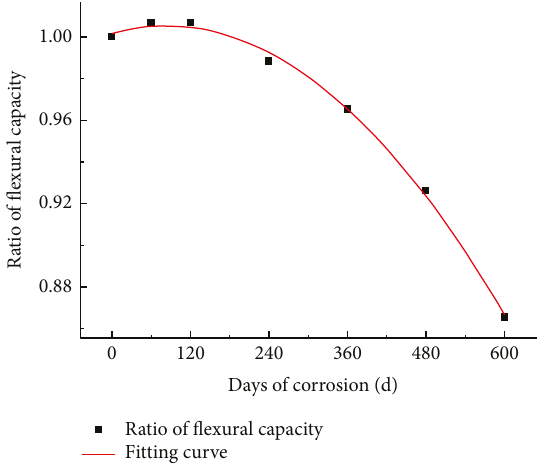
Figure 14: Fitting diagram of bending capacity with sulfate cor- rosion